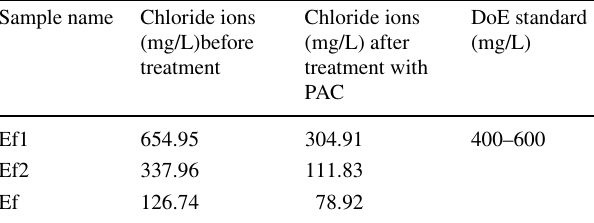
Table 7 Concentration of chloride ions of textile dyeing effluents